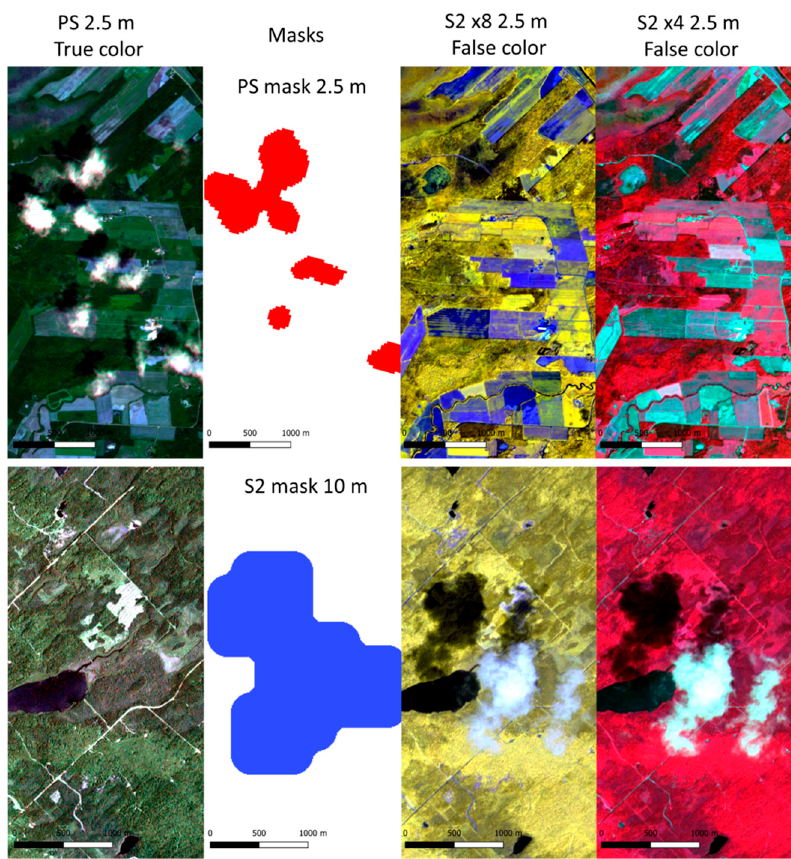
Figure 9. Effect of clouds and shadows on super ‐ resolved images resulting from the two neural networks (NNs), from 10 to 2.5 m (×4) and from 20 to 2.5 m (×8). First row: Presence of clouds and shadows in PlanetScope (PS) data. Second row: Presence of clouds and shadows in Sentinel ‐ 2 (S2) data. From left to right: PS at 2.5 m in true color (R, G, and B); PS mask at 2.5 m (red, top) or S2 mask at 10 m (blue, bottom); S2 from ×8 NN at 2.5 m in false color (B8a, B6, and B12); and S2 from ×4 NN at 2.5 m in false color (B8, B4, and B3).